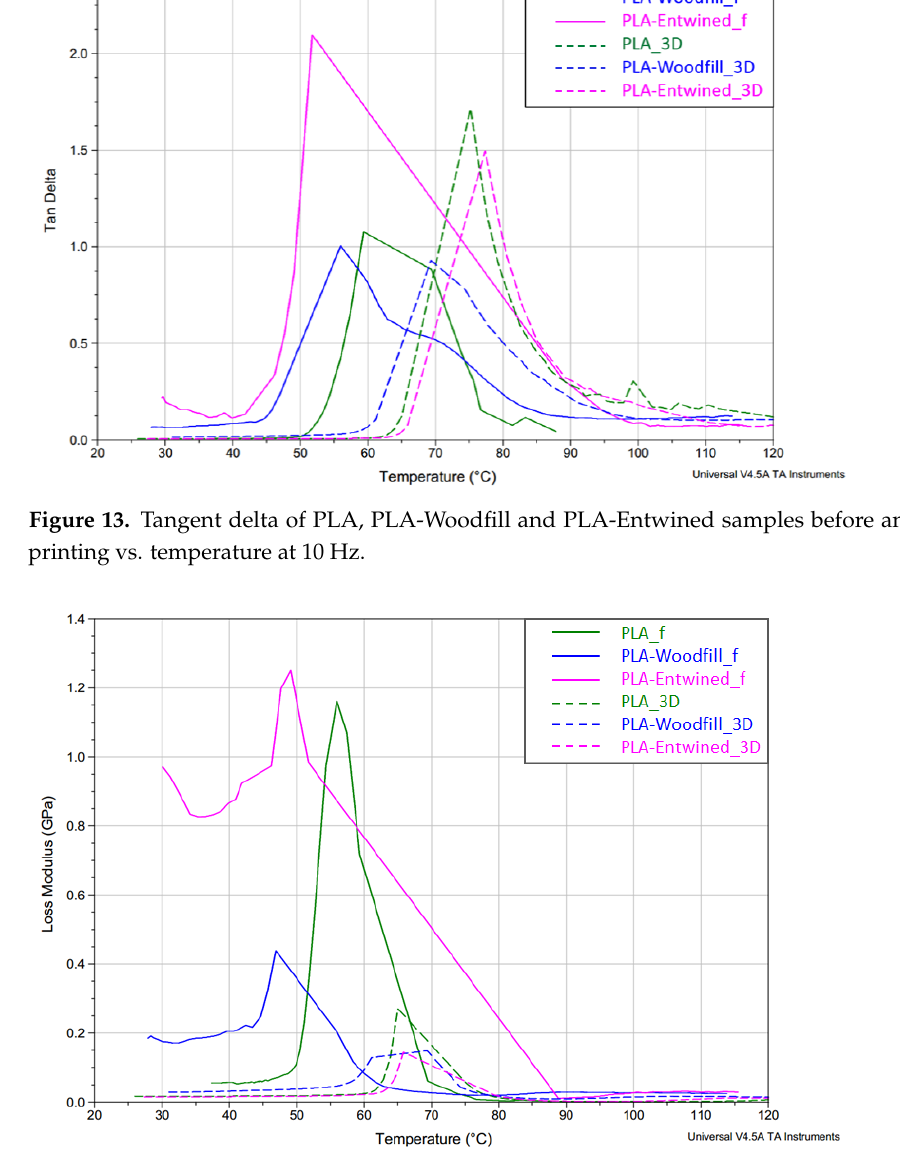
Figure 14. Loss modulus of PLA, PLA-Woodfill and PLA-Entwined samples before and after 3D printing vs. temperature at 10 Hz.